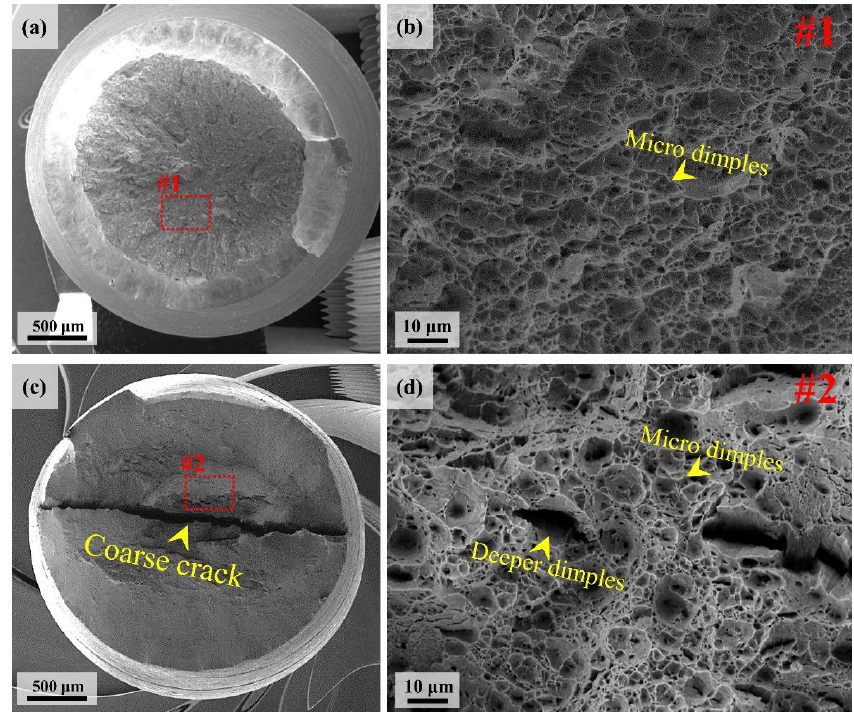
Figure 12. ( a ) SEM overview image of tensile fractography of alloy A; ( b ) high magnification SEM image of microscale dimples; ( c ) SEM overview image of tensile fractography of alloy B, and ( d ) high magnification SEM image of micro & deeper